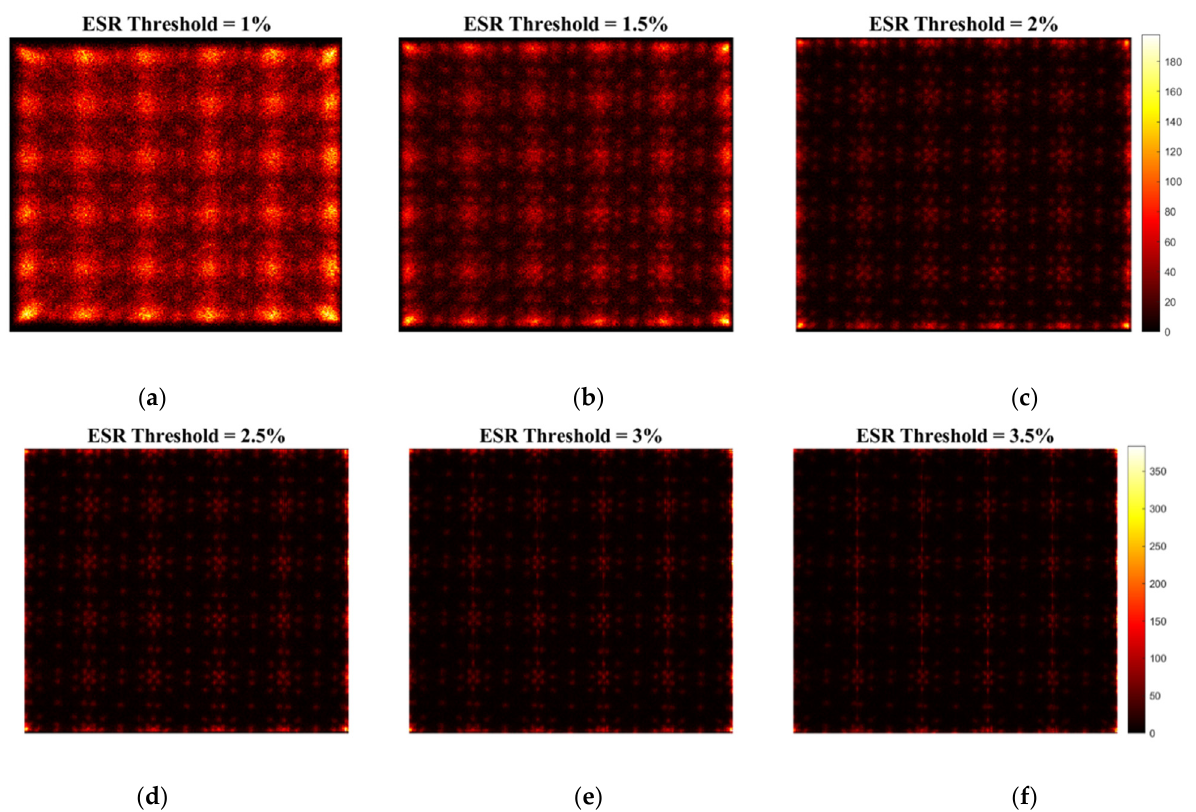
Figure 4. Flood histograms calculated from the experimental data of the dual-layer-offset crystal array constructed with ESR reflectors: ( a ) threshold = 1%, ( b ) threshold = 1.5%, ( c ) threshold = 2%, ( d ) threshold = 2.5%, ( e ) threshold = 3%, and ( f ) threshold = 3.5%.